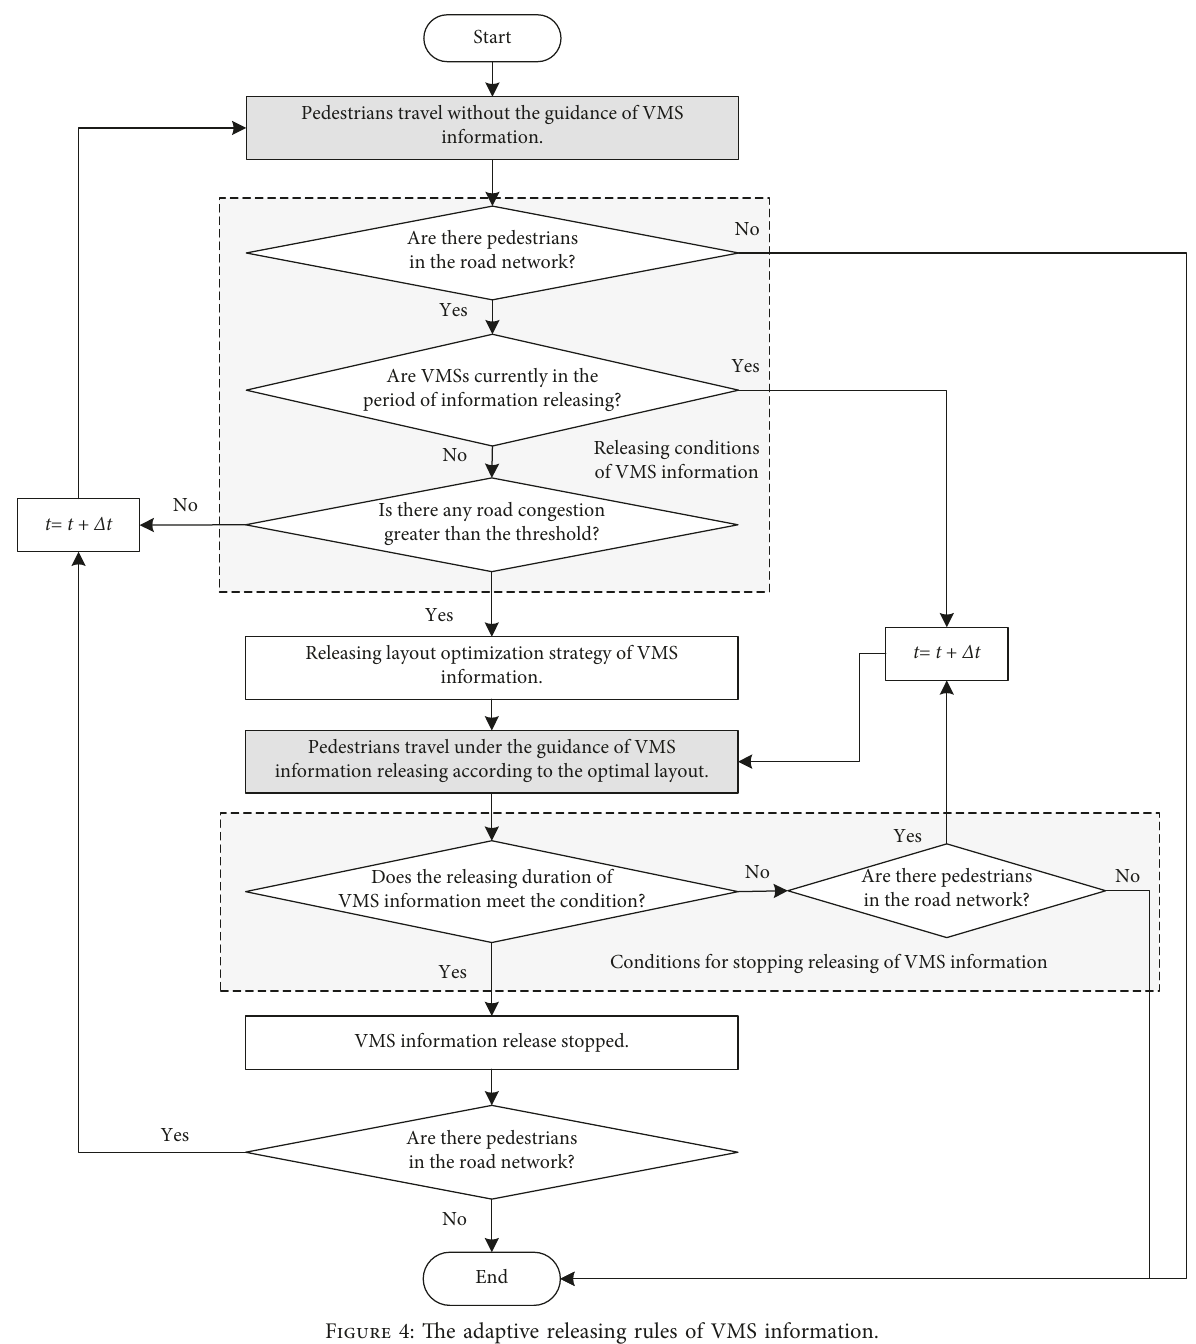
Figure 4: The adaptive releasing rules of VMS